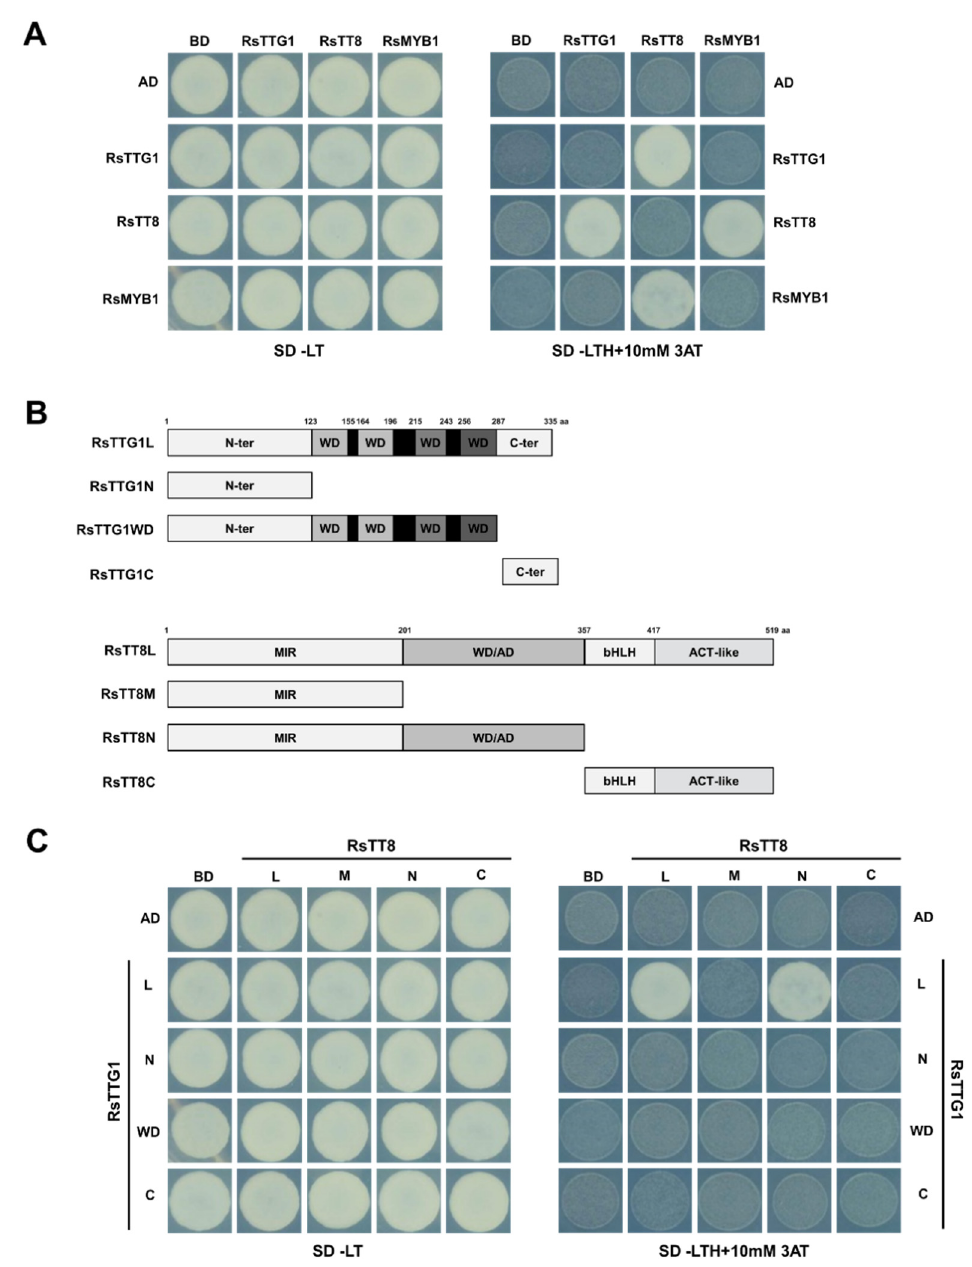
Figure 4. RsTTG1, RsTT8, and RsMYB1 form a ternary complex. ( A ) Interaction between RsTTG1, RsTT8, and RsMYB1 proteins, as revealed in a yeast two-hybrid (Y2H) analysis. ( B ) Schematic representation of constructs used to delineate the interaction interface between RsTTG1 and RsTT8. Amino acid positions are indicated in the diagrams. ( C ) Interactions between the truncated and full-length proteins of RsTTG1 and RsTT8. AD, activation domain; BD, binding domain; SD, synthetic defined medium; 3AT, 3-amino-1,2,4-triazole; SD/–TL, minimal medium lacking Trp and Leu; SD/– TLH + 3AT, synthetic defined medium lacking Trp, Leu, and His and containing 10 mM 3AT. 2.5. Transport of RsTTG1 to the Nucleus Depends on its Interactions with RsTT8